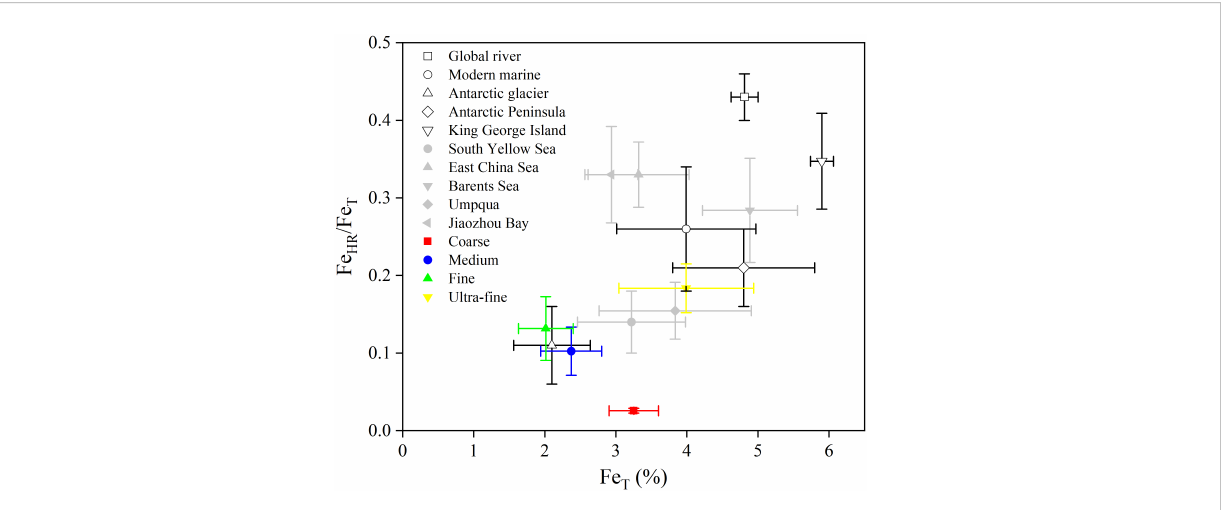
FIGURE 4 Comparison of Fe HR /Fe T and Fe T in “ Coarse ” , “ Medium ” , “ Fine ” and “ Ultra- fi ne ” categories of sediments from Prydz Bay and the adjacent Southern Ocean with global riverine particulates and modern marine sediments, Antarctic glaciers (Raiswell and Can fi eld, 1998; Poulton and Raiswell, 2002), off the western Antarctic Peninsula (Burdige and Christensen, 2022), off King George Island (Henkel et al., 2018), South Yellow Sea (Ma et al., 2018), East China Sea (Zhu et al., 2012), Barents Sea (Faust et al., 2021), Umpqua (Roy et al., 2013) and the Jiaozhou Bay (Zhu et al., 2015). Data are averages of surface sediments (0 – 2 cm) by recalculation of Henkel et al. (2018) and Burdige and Christensen